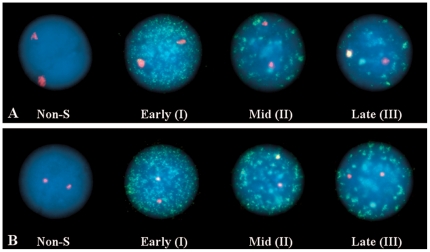
Heterochromatin configuration at different stages of the cell-cycle.BrdU pulse labelling (green), to visualise cells undergoing DNA synthesis (S phase), was used in conjunction with FISH with the D1Z1 probe (red) to identify a possible connection between the observed variability in the configuration of chromosome 1 juxtacentromeric heterochromatin and progression through the cell-cycle. Comparative tests were conducted in both ICF and controls. No differences were observed in the heterochromatin organisation when comparing B-cell nuclei in both ICF and control cells, with “conventional” (A) and “compact” (B) hybridisation patterns equally present in non-S phase and the various stages of the S phase of the cell-cycle. Examples above belong to a miscellanea of informative pictures collected from both ICF and control cells. S phase progression patterns as described in O'Keefe [23].